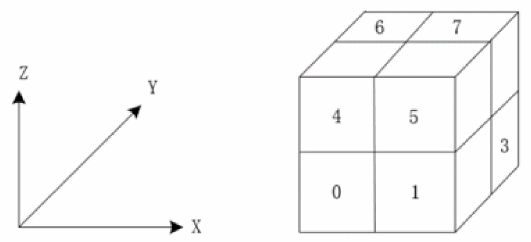
Figure 3. Octree partition space